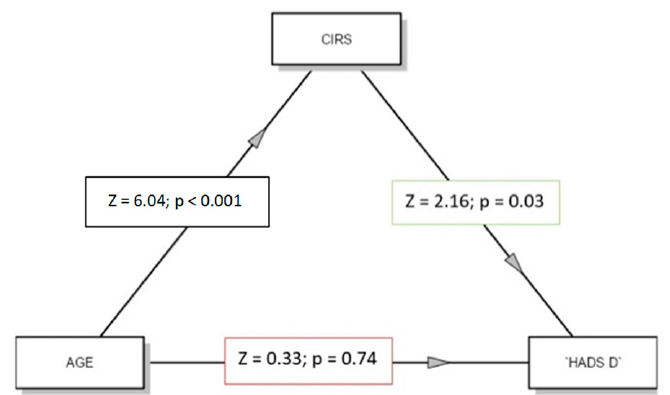
Figure 4. Representation through model diagram of mediation effect of CIRS.